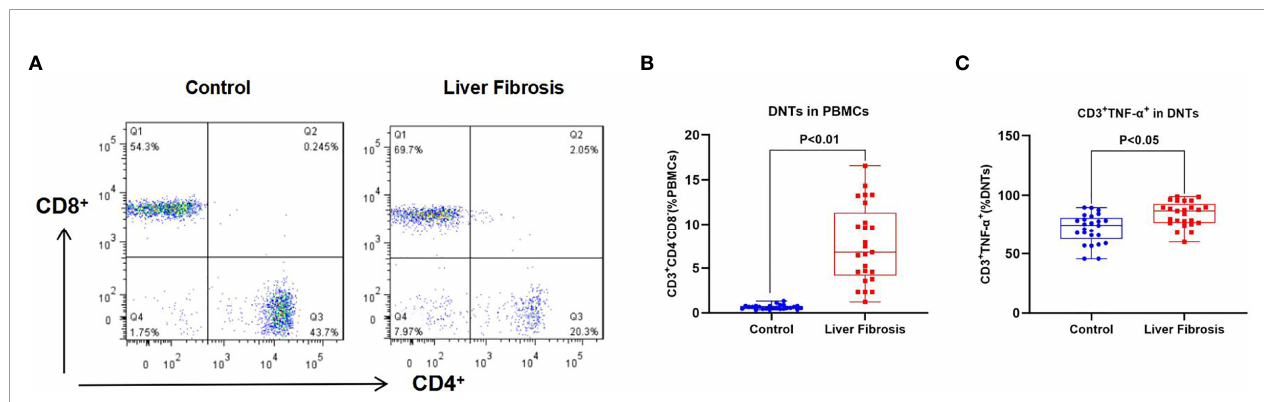
FIGURE 1 | Proportion of DNTs in peripheral blood of liver fi brosis patients. (A, B) Proportion of DNTs in PBMCs. The proportion of DNTs in peripheral blood of liver fi brosis patients was remarkably higher than that in healthy controls. (C) Proportion of CD3 + TNF- a + cells in DNTs. The proportion of CD3 + TNF- a + cells in DNTs was evidently elevated in liver fi brosis patients, which was higher than that in healthy control, suggesting that TNF- a was highly expressed in DNTs of liver fi brosis patients. DNTs, double-negative T cells; PBMCs, peripheral blood mononuclear